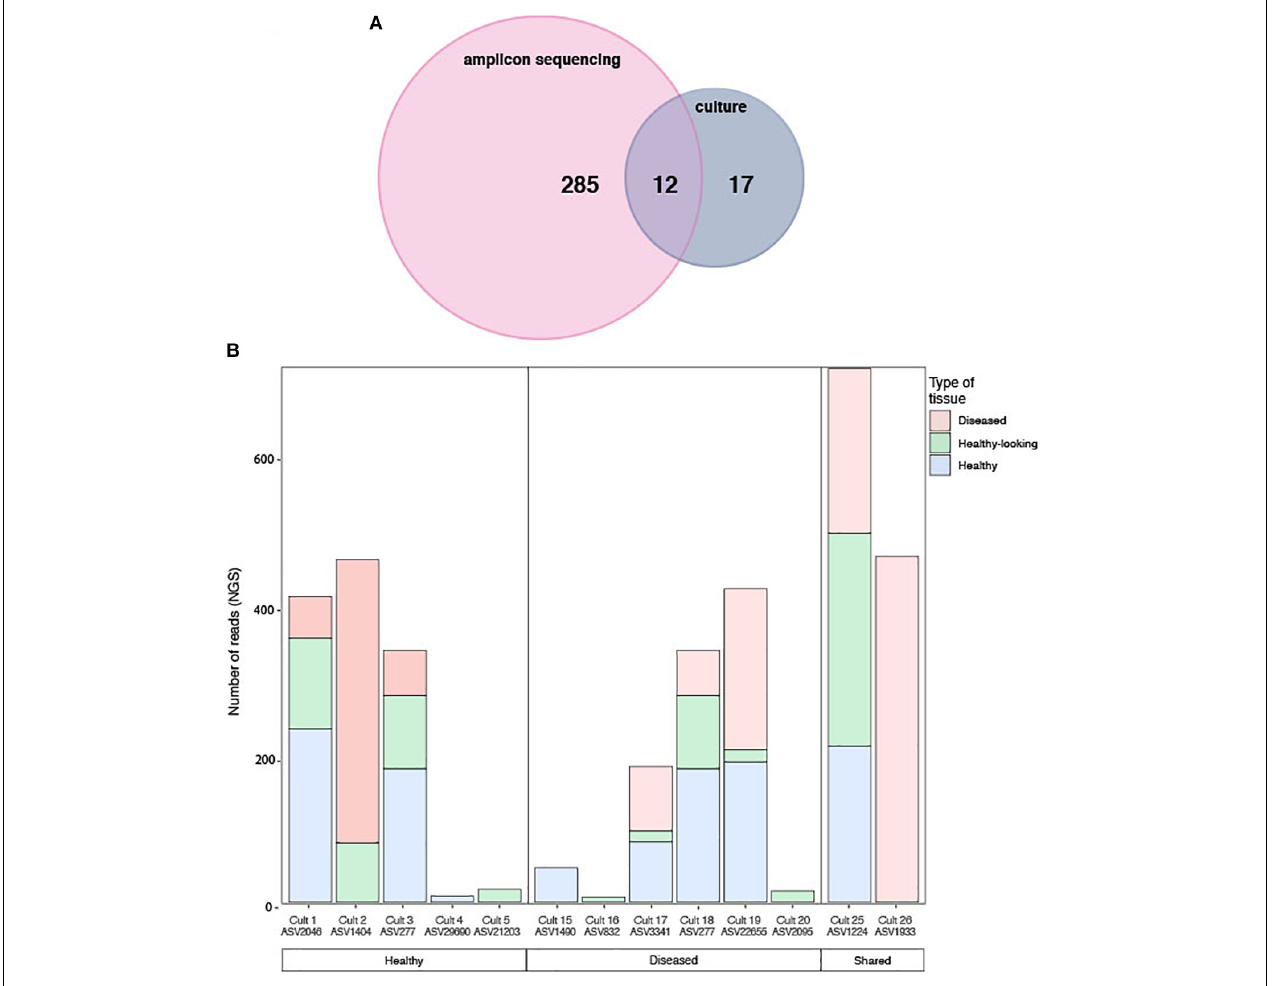
FIGURE 7 | (A) Venn diagram of shared sequences between the ASVs obtained through amplicon sequencing and the cultured strains. (B) Number of sequences obtained by amplicon sequencing in healthy and diseased CCA samples for each of the 12 matching bacterial strain isolates exclusively in each health groups. Both the culture name and its ASVs equivalent are